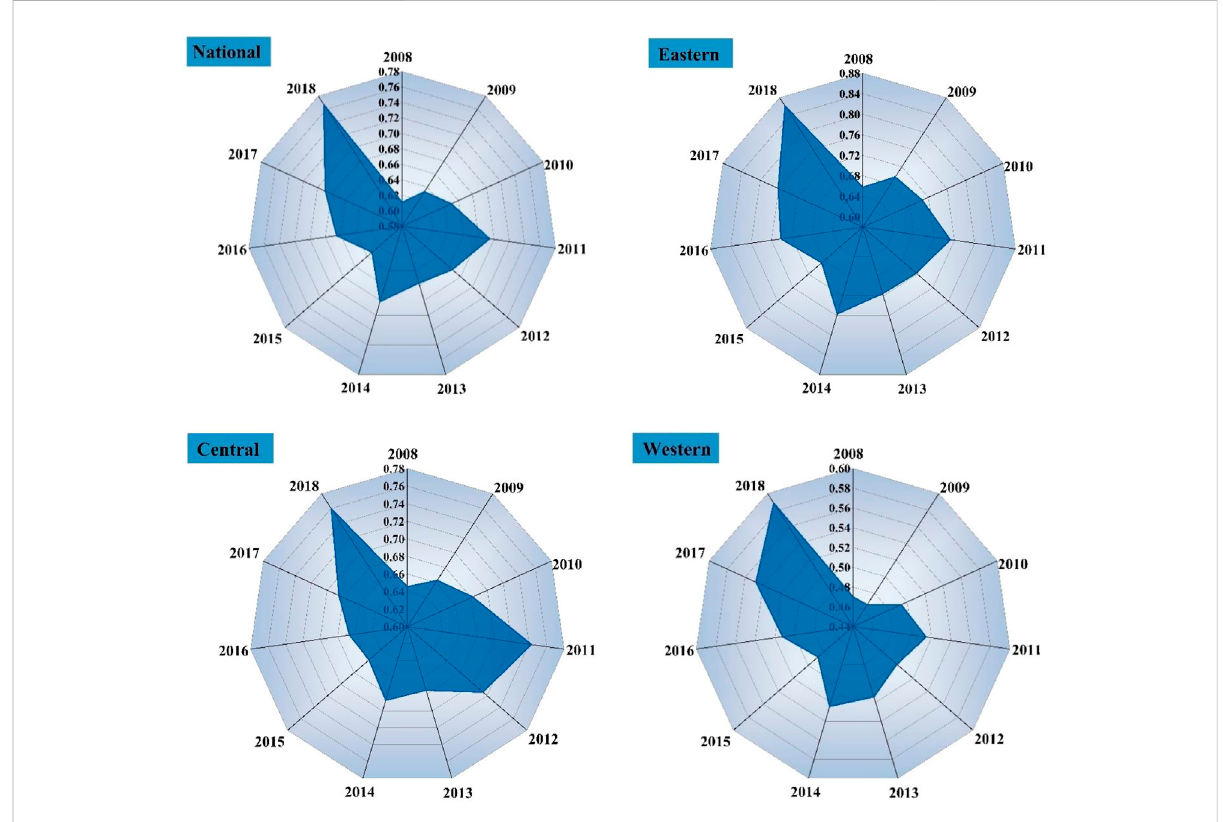
FIGURE 3 Temporal distribution characteristics of